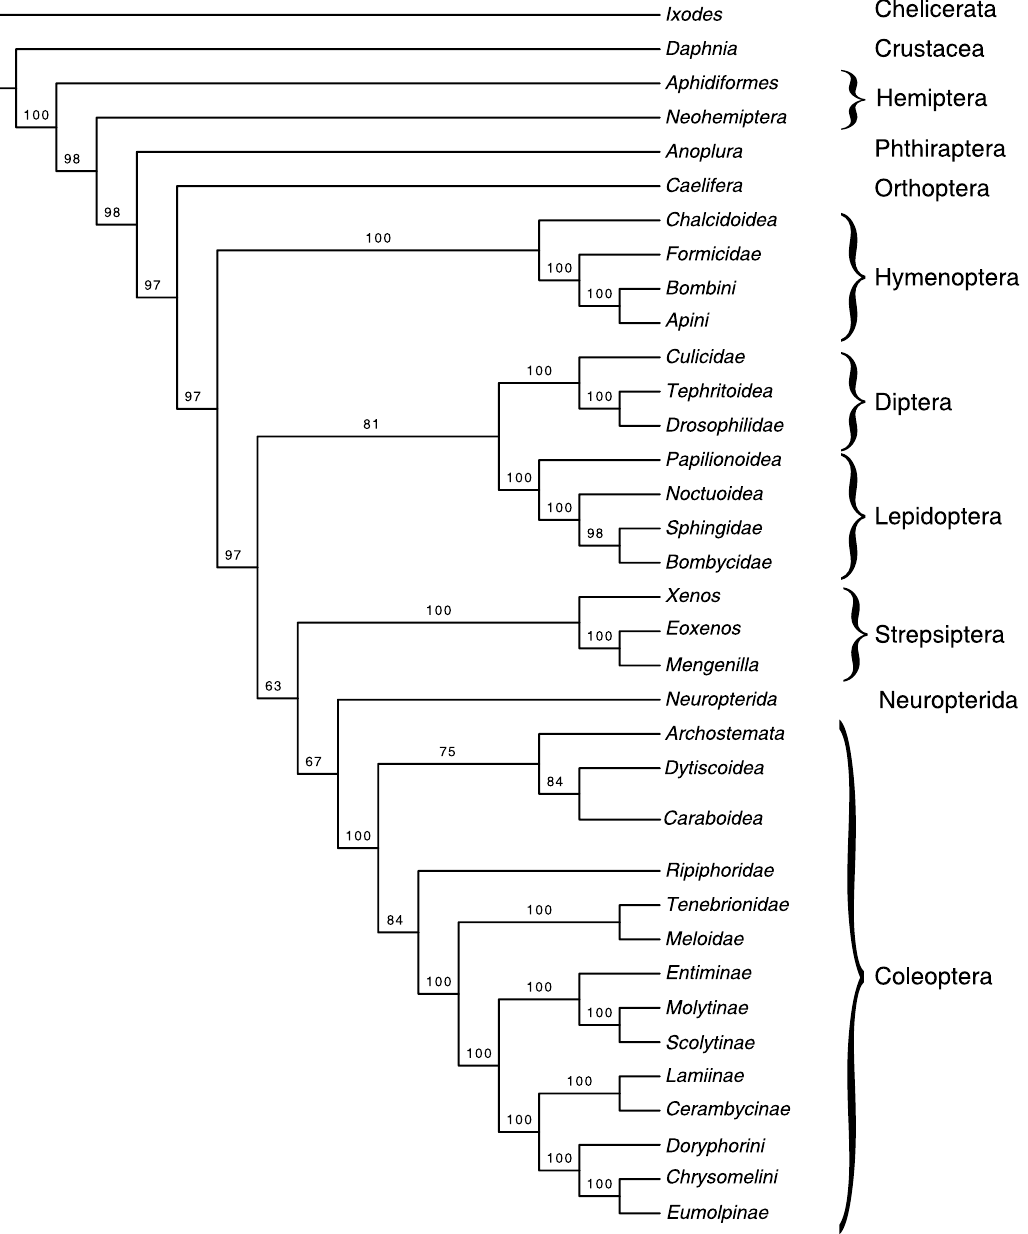
Figure 2. Phylogenetic tree reconstructed using Maximum Parsimony.